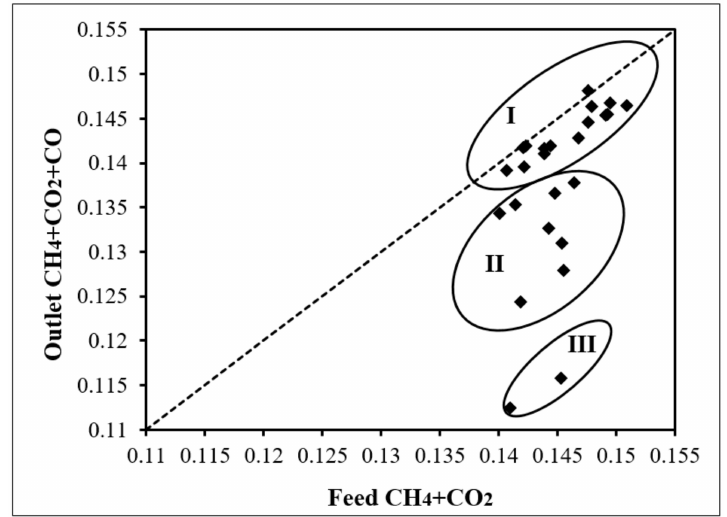
Figure 3. Carbon balance for all runs over Ru / CNT-zeolite. Circle I: 773, 823, 873 K; Circle II: 923, 973 K; Circle III: 973 K at higher feed CH 4 / CO 2